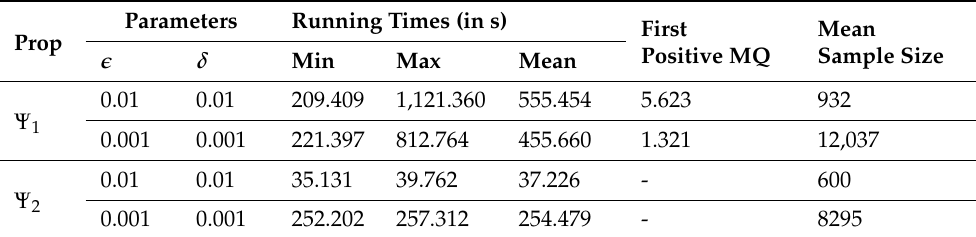
Table 10. Hadoop file system logs: On-the-fly